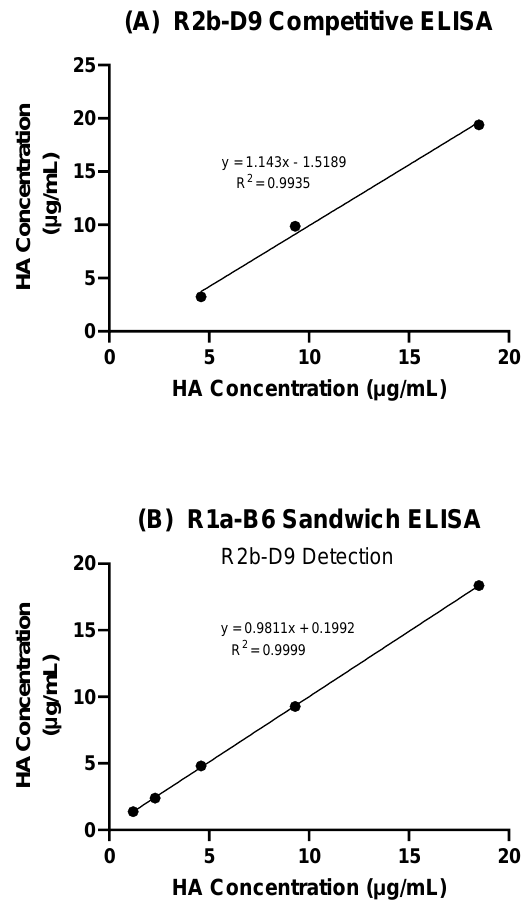
Figure 5. Detection limit and linearity. ( A ) Antigen reagent 09/196 was diluted in 2-fold steps in triplicate, and each dilution was independently analysed by competitive ELISA using R2b-D9 and ( B ) sandwich ELISA using R1a-B6 as capture antibody and R2b-D9 as primary detection antibody. Estimated potency for each dilution is plotted against expected concentration.